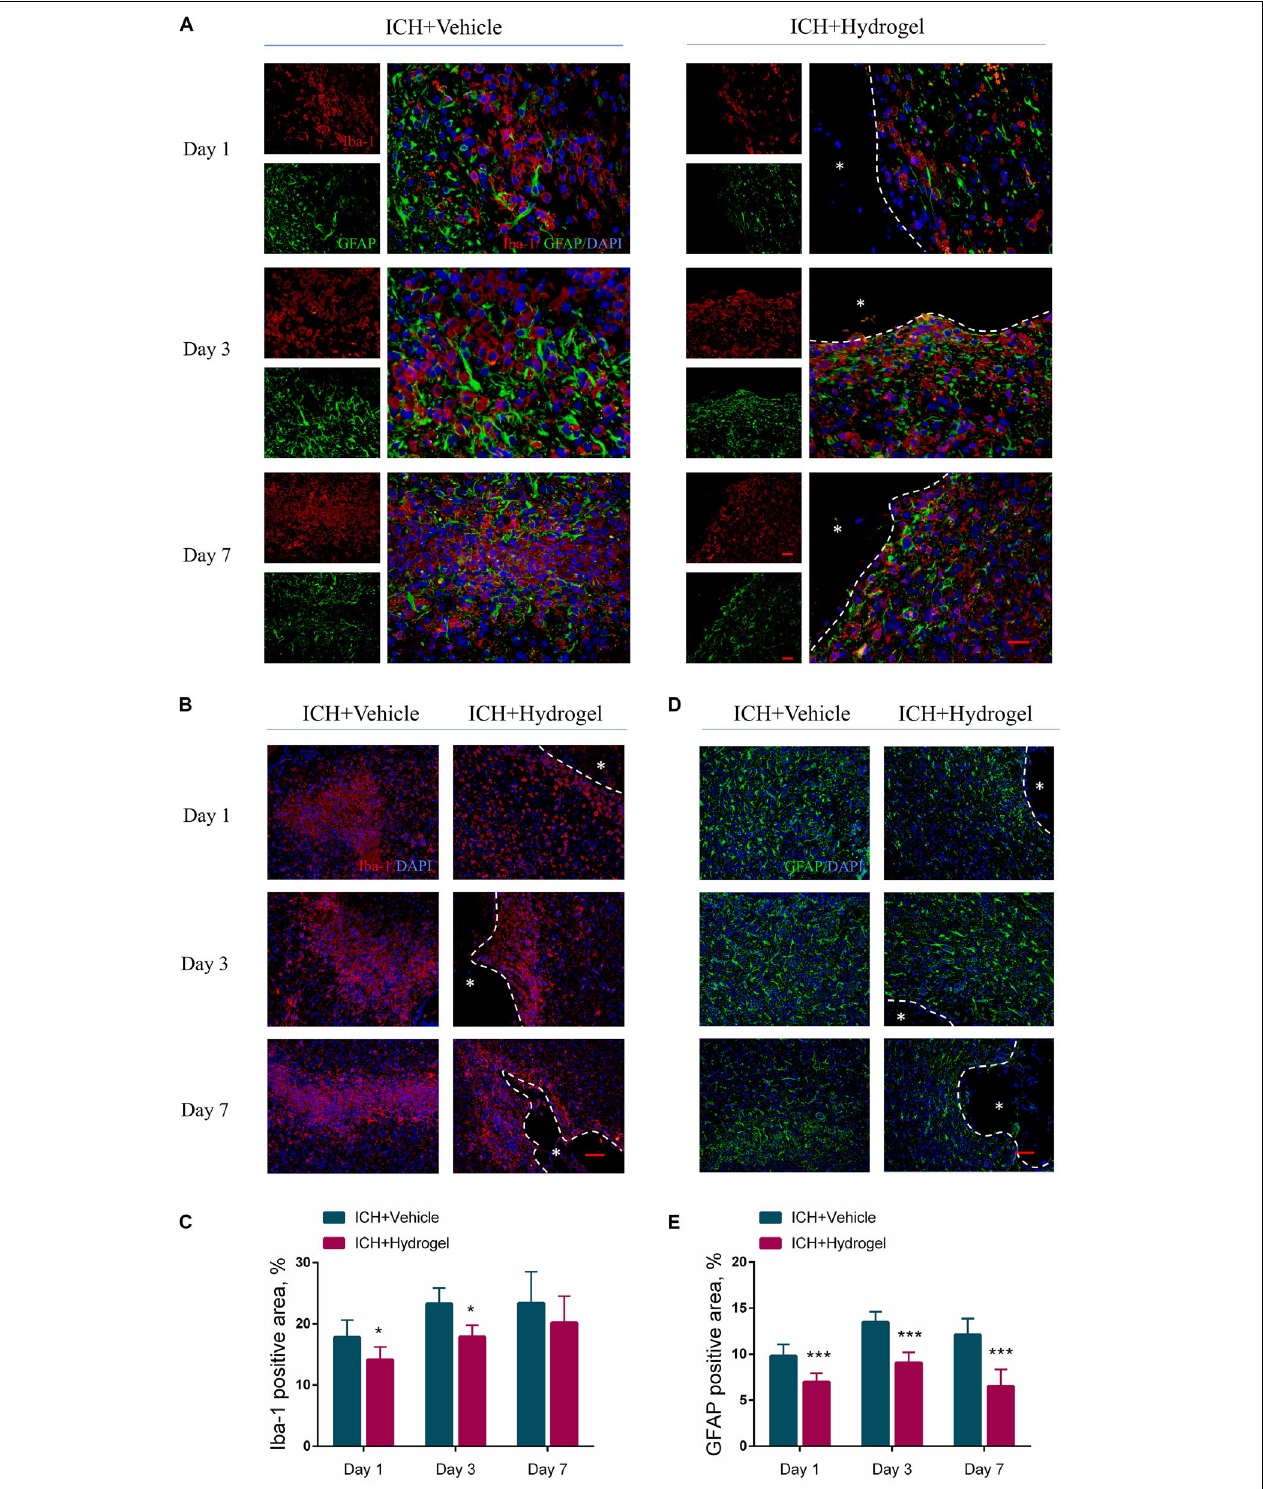
FIGURE 5 | Gelatin hydrogel affects the activation of microglia/macrophages and astrocytes. (A) Double immunofluorescence staining was performed with astrocyte marker GFAP (green) and microglia/macrophages marker Iba-1 (red) in brain sections, scale bar = 20 µ m. (B) Representative images for Immunofluorescence staining of Iba-1, scale bar = 50 µ m. (C) The percentage of Iba-1 positive area analysis. (D) Representative images for Immunofluorescence staining of GFAP, scale bar = 50 µ m. (E) The percentage of GFAP positive area analysis. *Represents the hydrogel. Data are mean ± SD, n = 4 mice per group, * P < 0.05, *** P < 0.001.